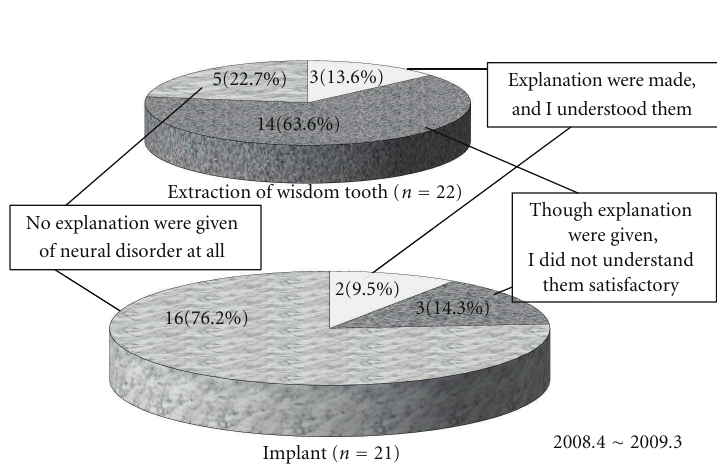
Figure 6: Questionnaire on preoperative informed consent